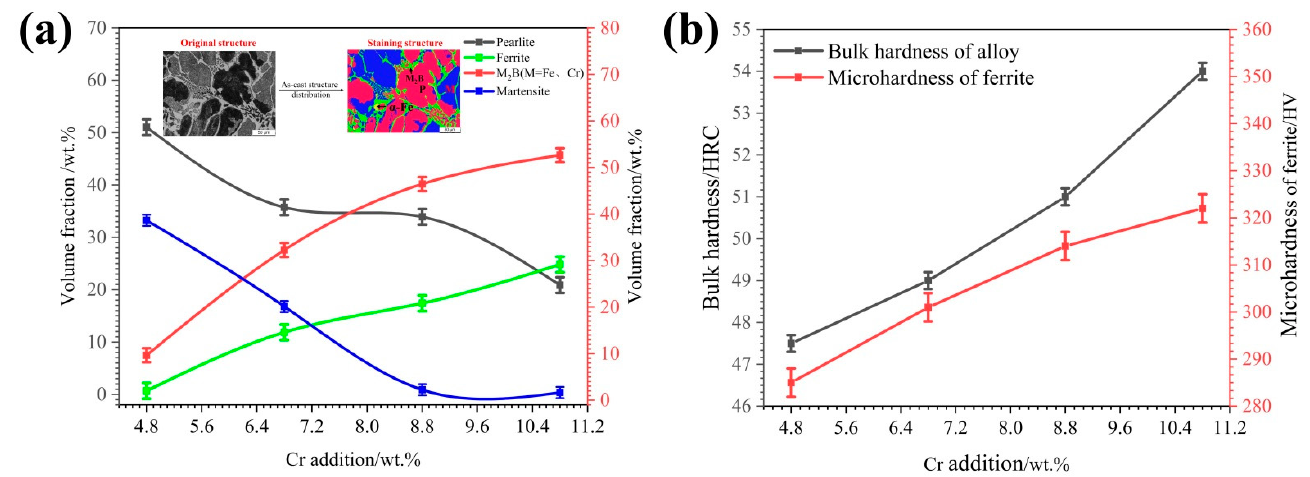
Figure 4. Volume fraction of various microstructures in HBHSSs and bulk hardness, as well as ferrite microhardness:( a ) volume fraction vs. Cr content, ( b ) the bulk hardness and microhardness of ferrite matrix vs. Cr content.